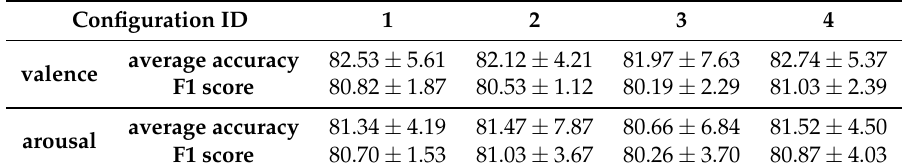
Table 8. The performances of different configurations of Hybrid ResNet-LSTM for valence and arousal. Accuracies (%) and F1 score (%) are subject to 10-fold cross